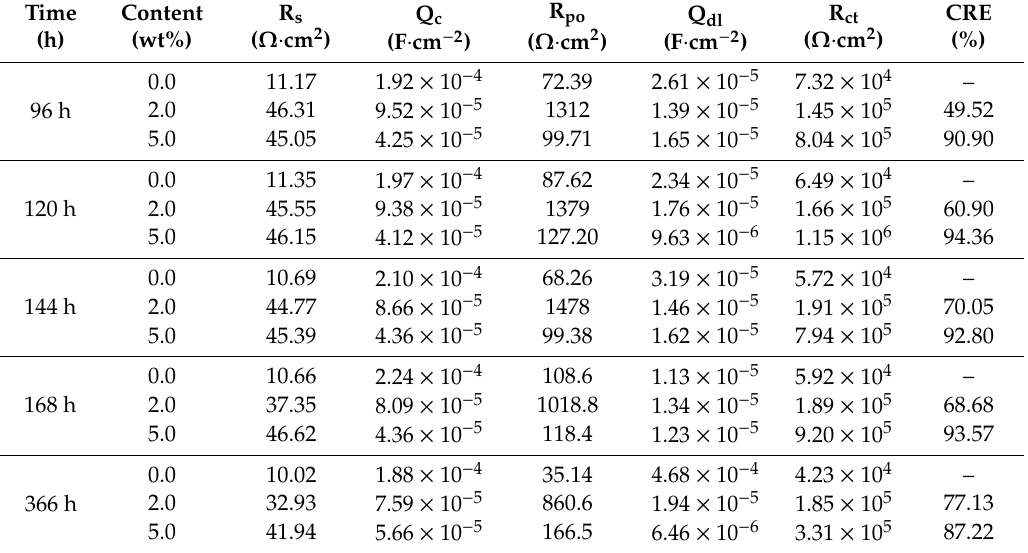
Table 2. EIS parameters of the scratched coating with immersion in